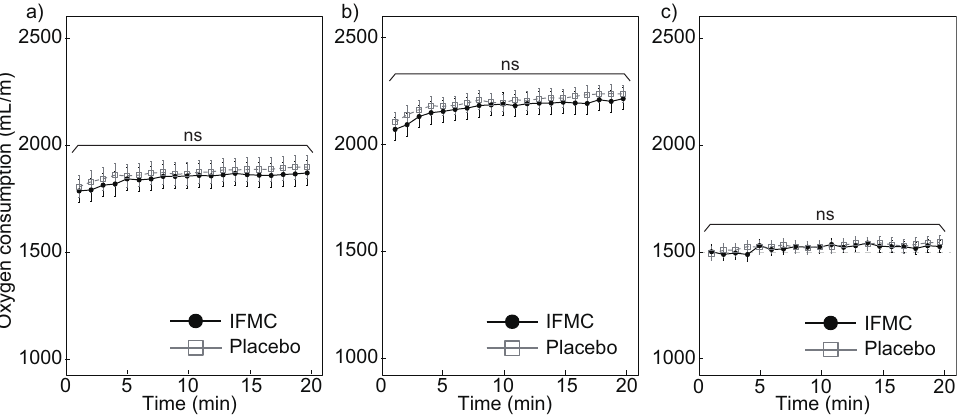
Figure 4. Differences in ( a ) all, ( b ) male, and ( c ) female oxygen consumption over 20 min between IFMC and placebo applications. The “ns” stands for “not significant ( p >